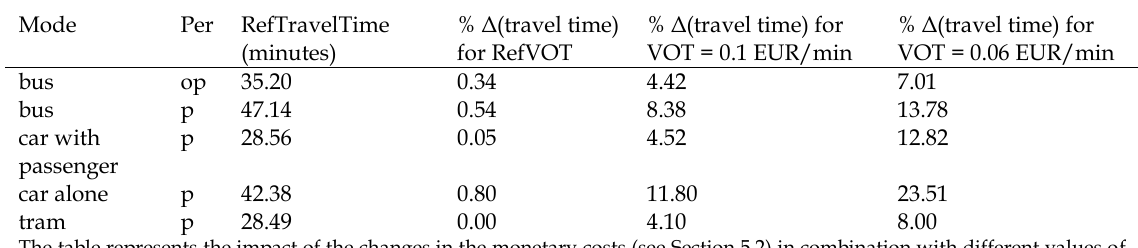
% Changes in travel time for changes in